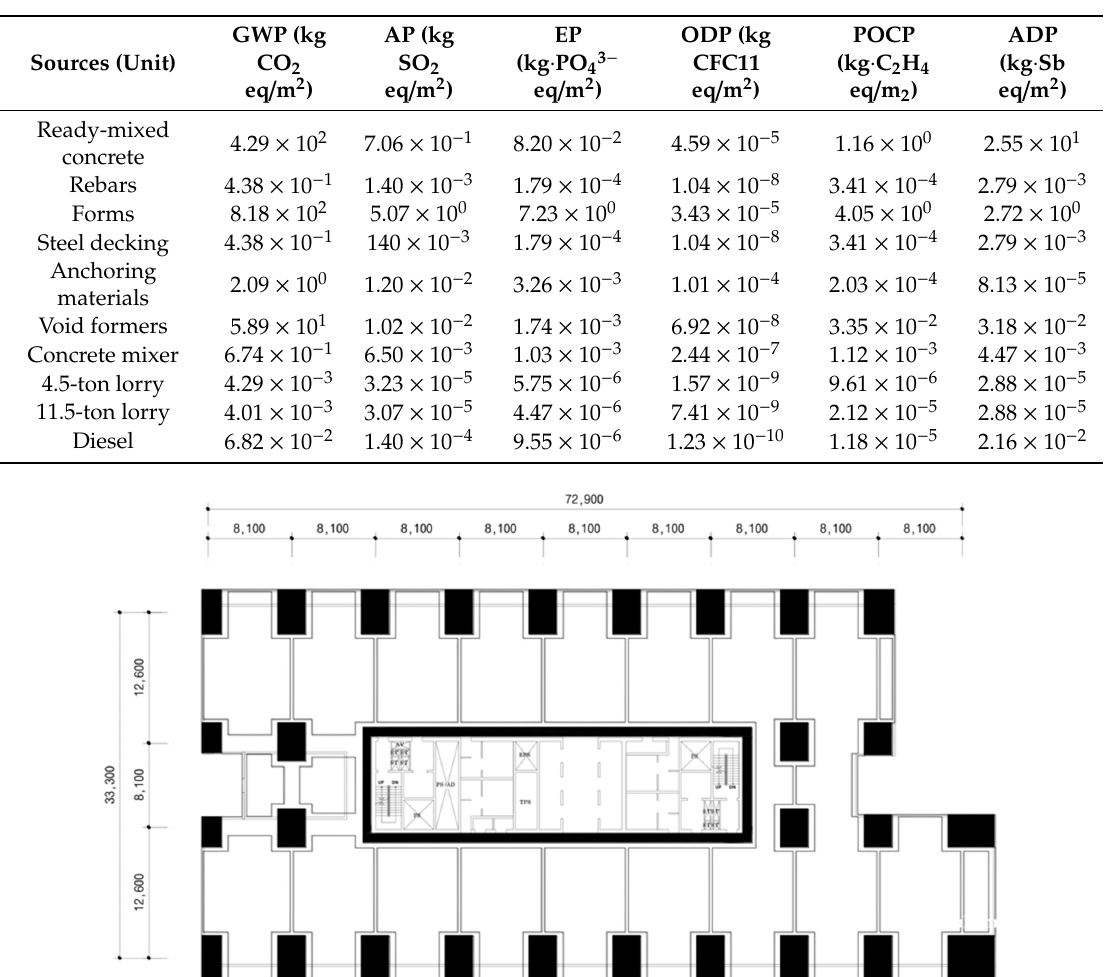
Table 3. Factors of environmental impacts.